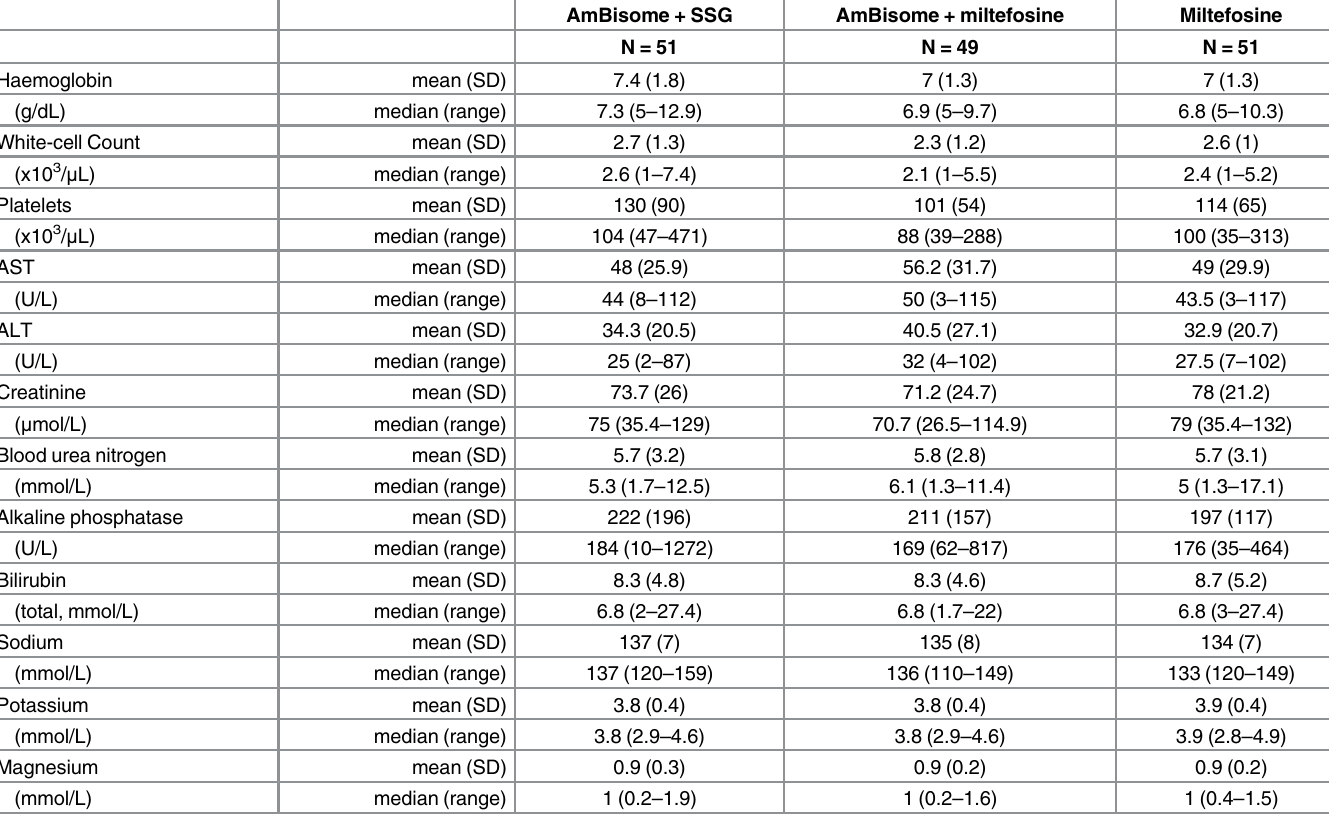
Table 4. Baseline laboratory